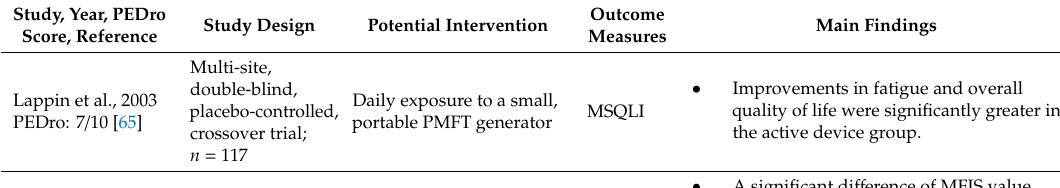
Table 4. Clinical studies of magnetic field therapy in patients with MS-related